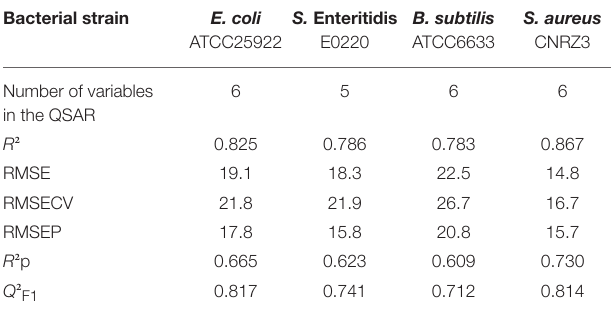
Frontiers in Microbiology |